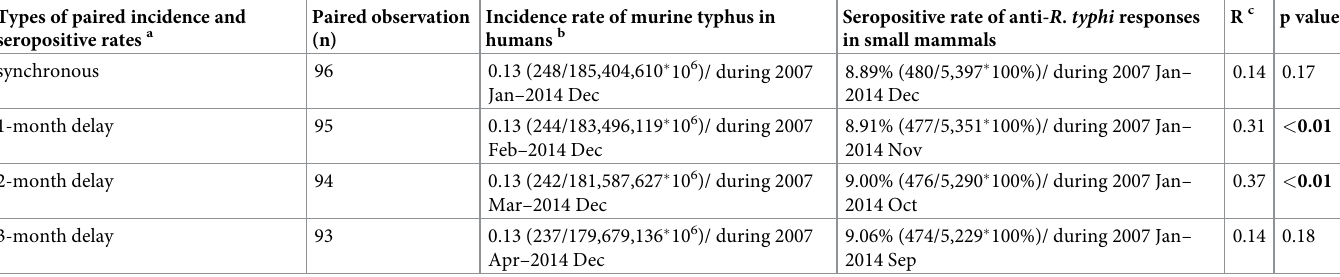
Table 1. Correlation between the incidence rate of indigenous murine typhus in humans and seropositive rate of anti- R . typhi responses in small mammals from 2007–2014. Types of paired incidence and seropositive rates